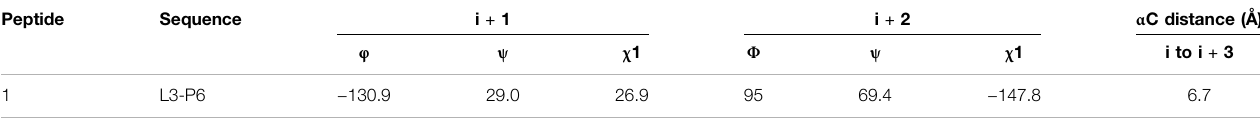
TABLE 5 | Mean values of φ , ψ , and χ 1 angles and α C distances relative to the most representative conformers of 1 . Peptide Sequence